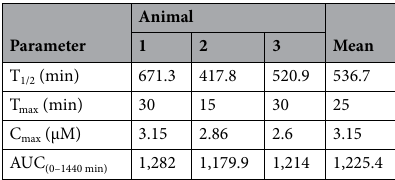
Table 3. PK parameters of compound 1.